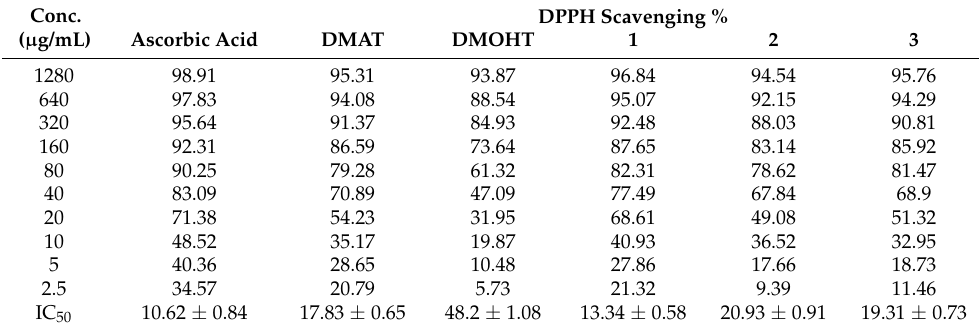
Table 7. The antioxidant activity of the studied